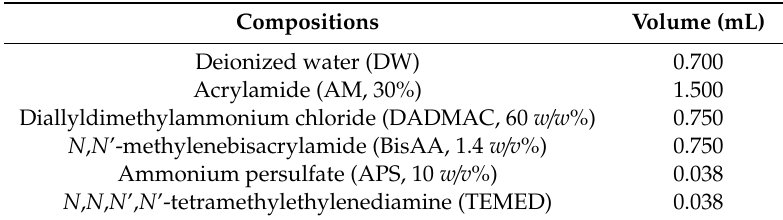
Table 1. CompositionratioofthePAD(poly(acrylamide- co